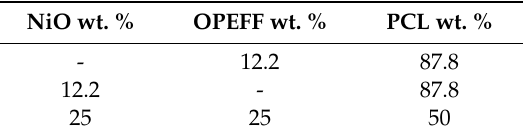
Table 1. Composition of three substrates